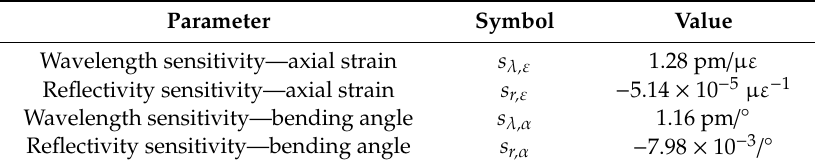
Table 2. Coe ffi cients of the sensitivity matrix obtained on the FBG Table 2. Coefficients of the sensitivity matrix obtained on the FBG characterization.